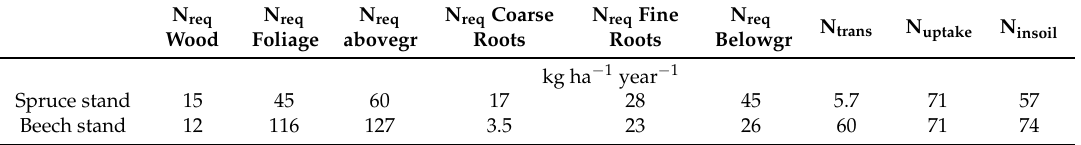
Table 9. Nitrogen allocation in spruce and beech stands (kg N · ha − 1 · year − 1 ). Annual